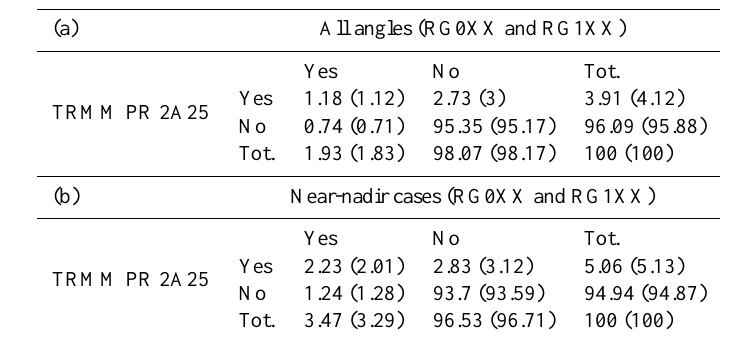
Table 2. Contingency matrices for TRMM 2A25 V7 surface rain rate and 10min raingauge rain rates for (a) all angles and (b) near-nadir cases. Counts are expressed as a percentage of the total number of observations. Values in parentheses are for V6. The 10min timescale is centered over the time of the satellite overpass during June 2008–May 2011.